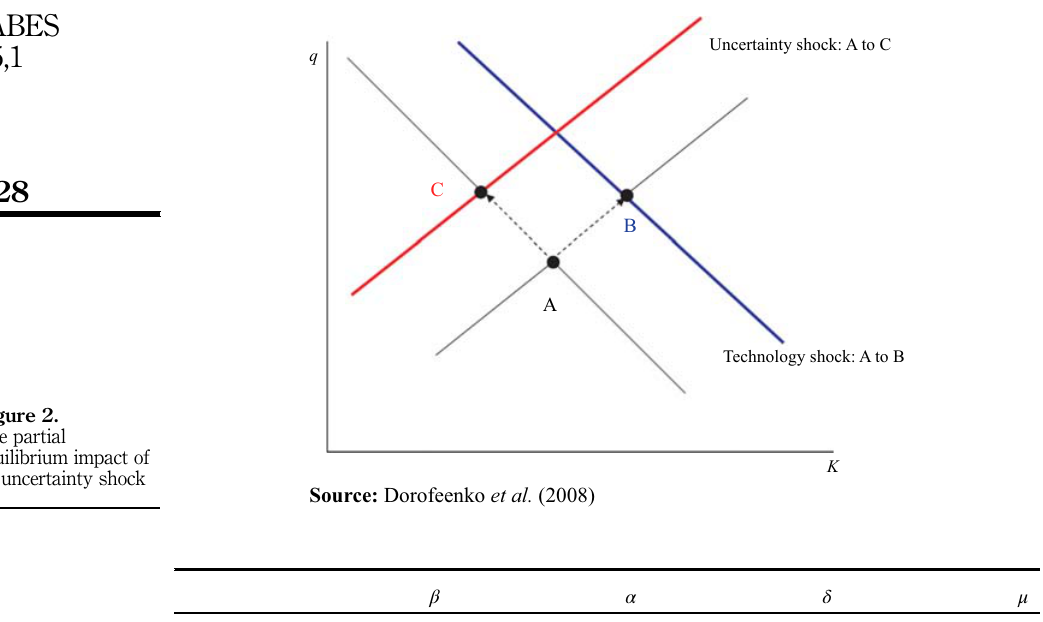
Table II. Parameter values